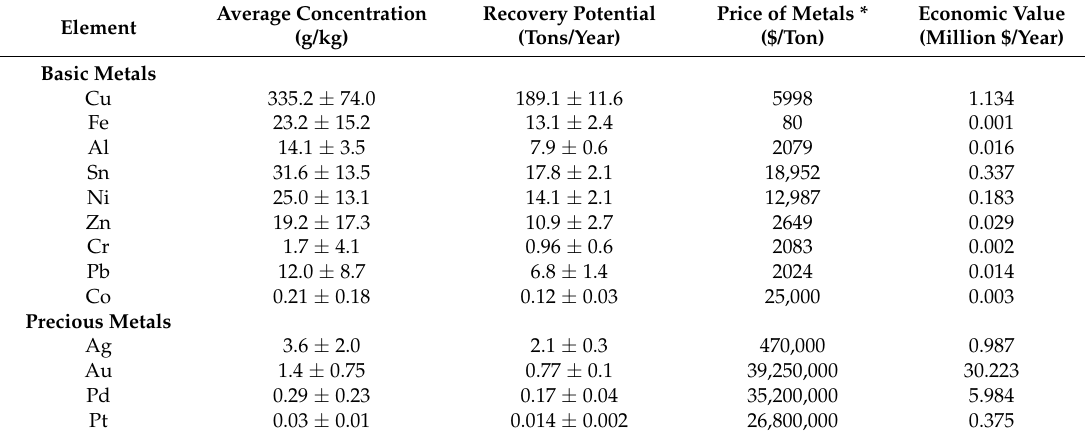
Table 9. Average metal concentrations and recovery potentials of metals from printed circuit boards of mobile